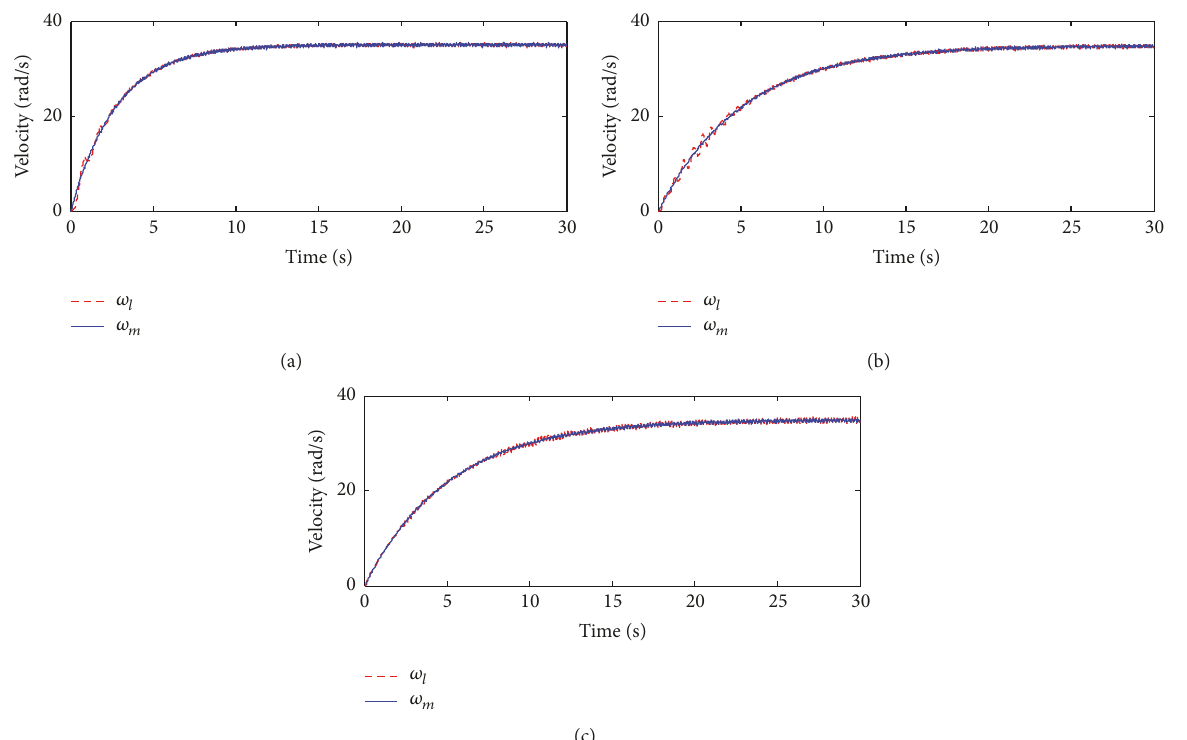
Figure 11: The experimental velocity responses of load side with different springs (𝑞 = 0.131) : (a) spring 1, 𝐾 𝑝 = 0.0089, 𝐾 𝑖 = 0.5 ; (b) spring 2, 𝐾 𝑝 = 0.0138, 𝐾 𝑖 = 1.1943 ; (c) spring 3, 𝐾 𝑝 = 0.0162, 𝐾 𝑖 = 1.653 .